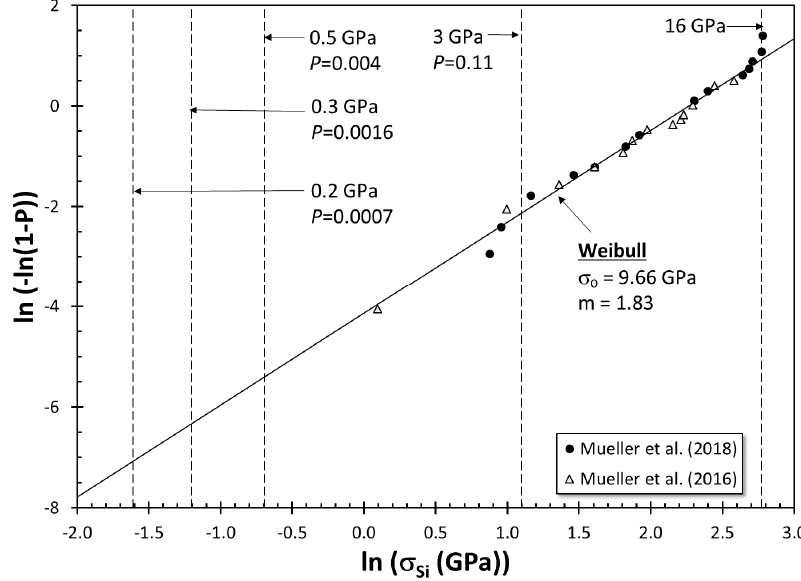
Figure 7. The Weibull probability plot of Si particle fracture stresses as measured by Mueller et al. (data from [108,109]).